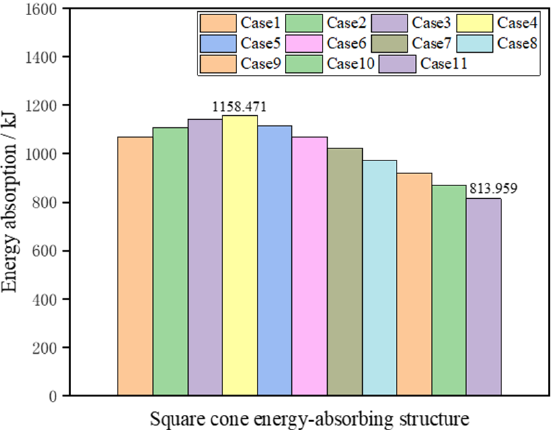
Figure 14. Influence of the platform force changes on square cone energy-absorbing structure.